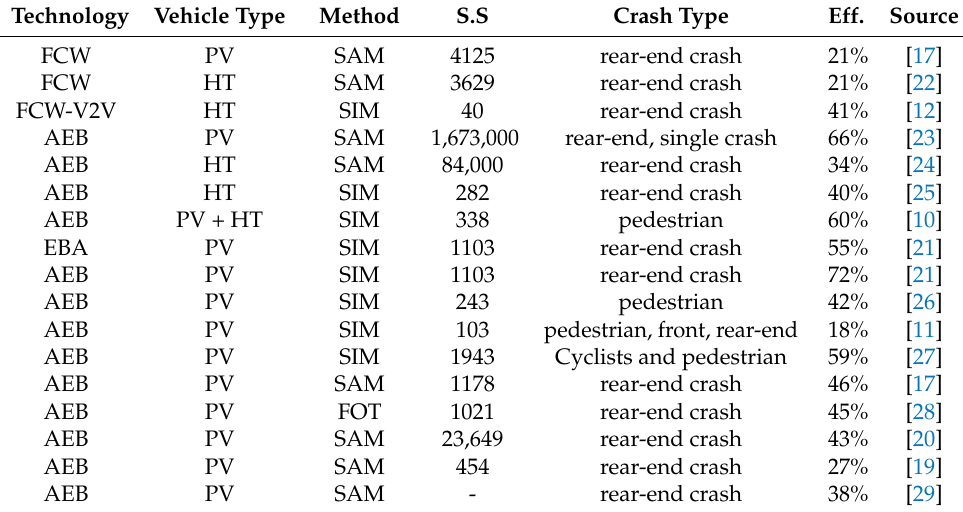
Table 1. Evidence for the crash avoidance effectiveness of AEB and